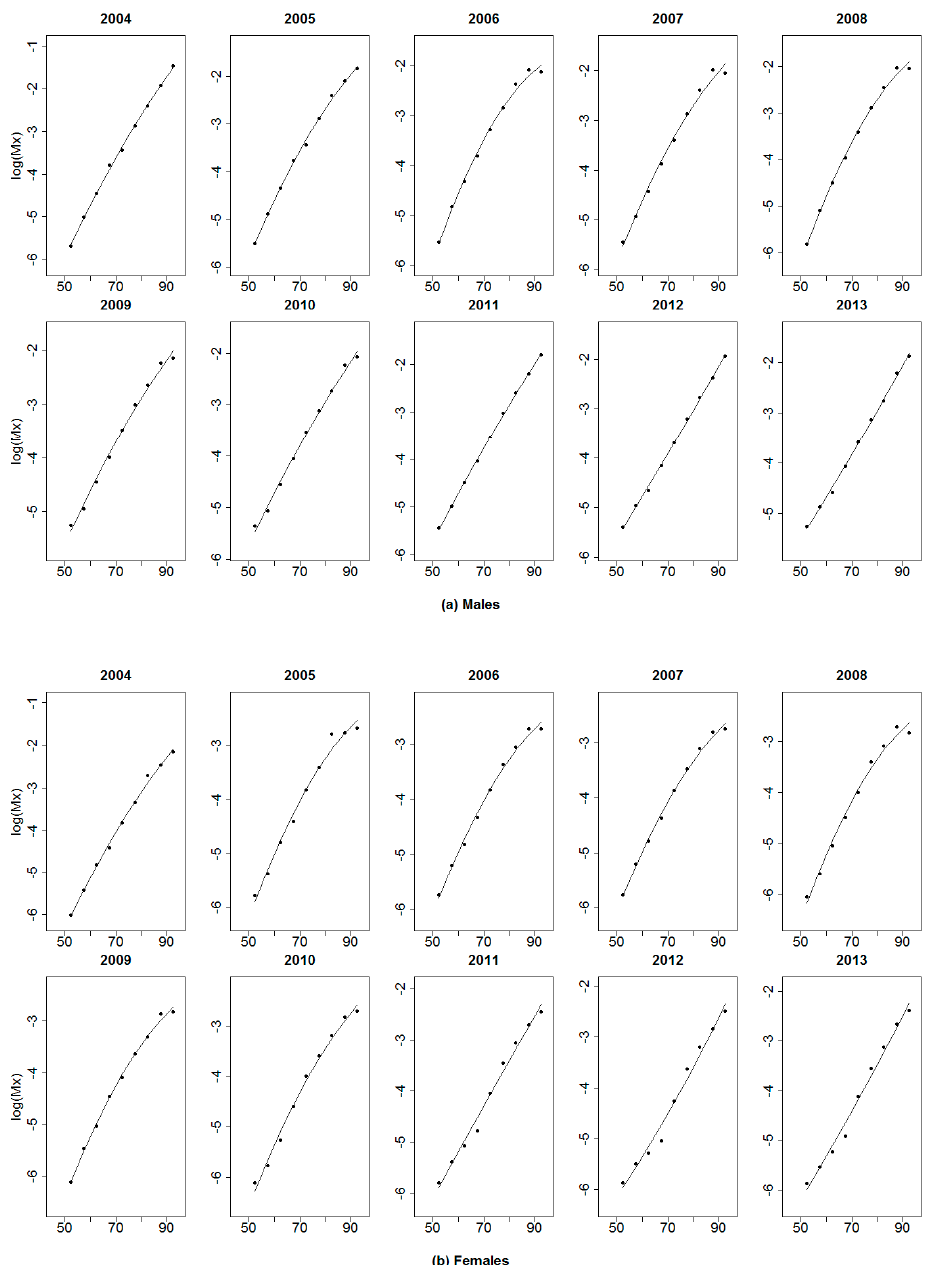
Figure 3. Annual life-tables fitting. Each subplot represents the death rates for the five age intervals observed during each year from 2004 to 2013 for: males ( a ); and females ( b ). The continuous lines represent the quadratic fits.